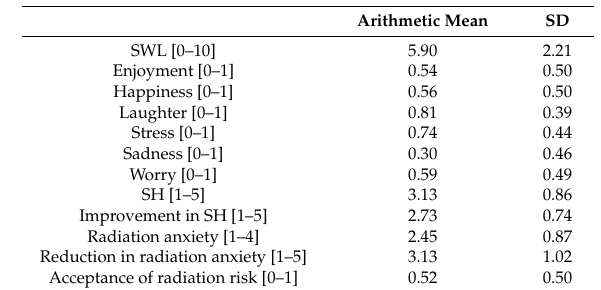
Table 5. Arithmetic mean and standard deviation (SD) of scores for each outcome. Values in square brackets represent ranges of